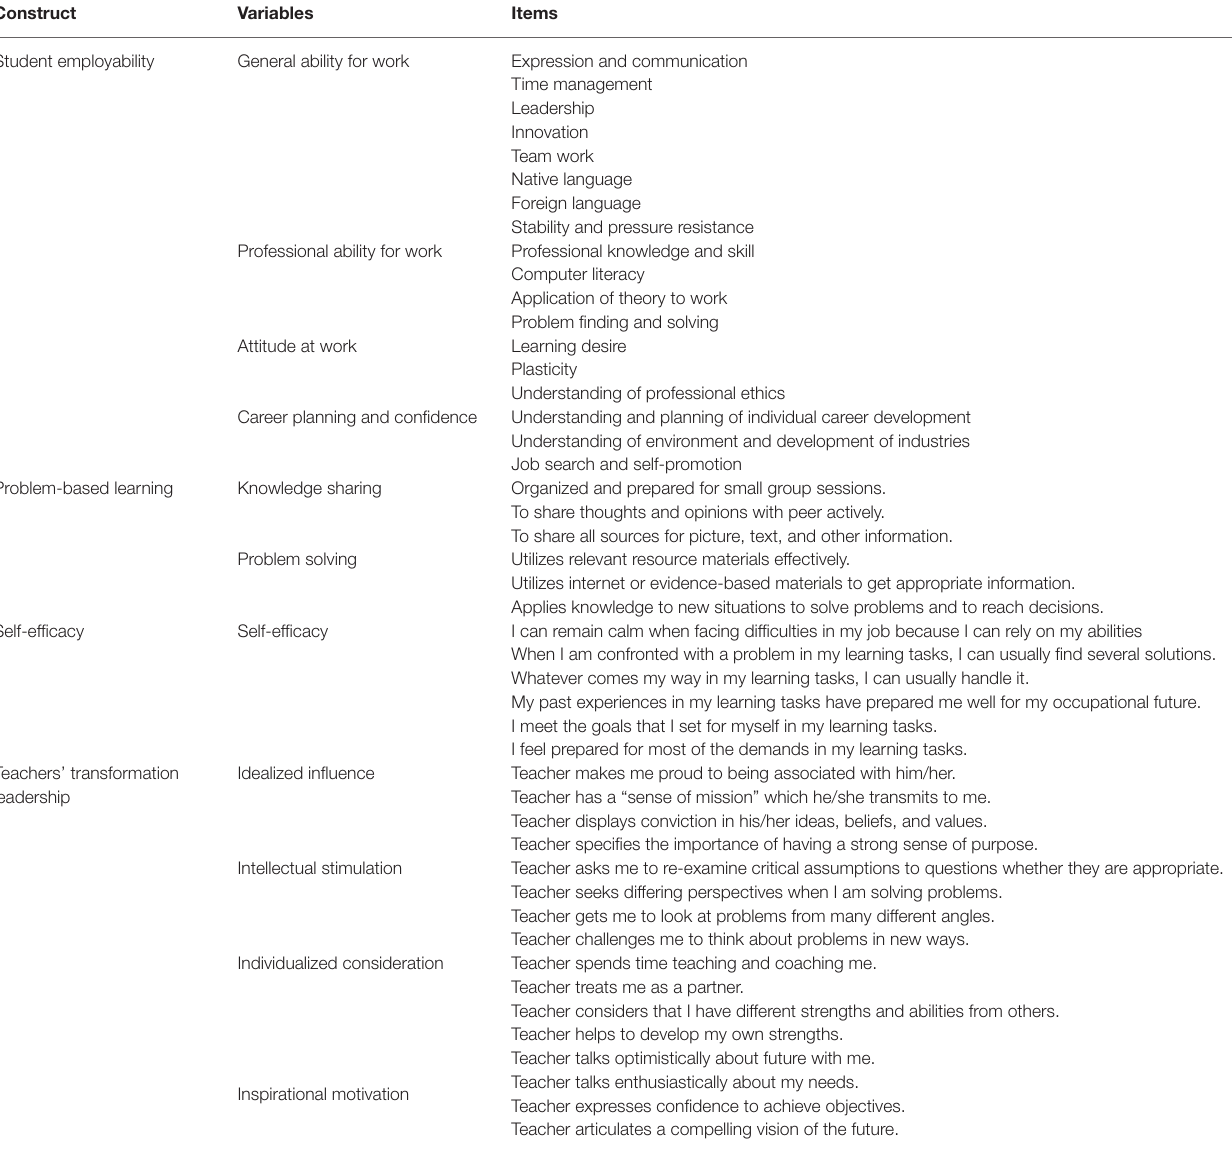
TABLE 1 | Instruments